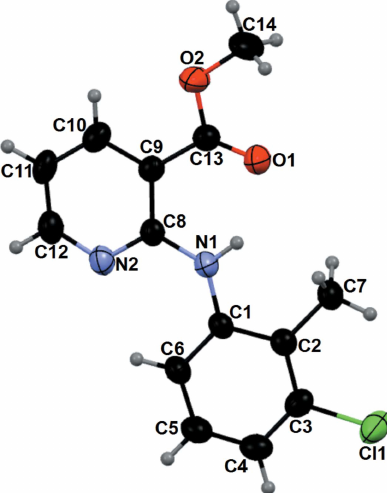
Figure 1 The molecular structure of the title compound with displacement ellipsoids drawn at the 50% probability level.